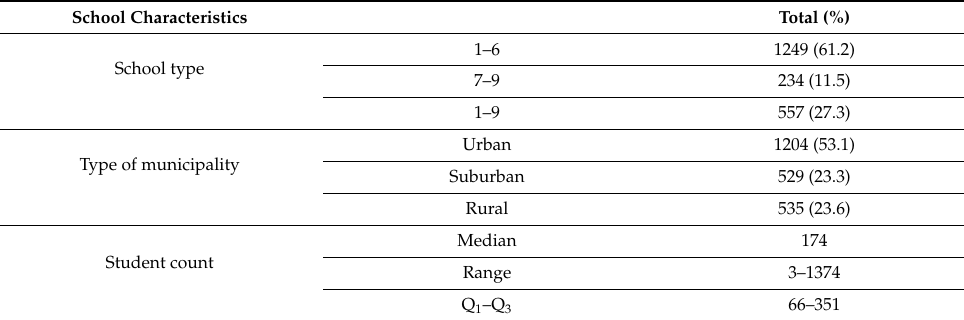
Table 1. School characteristics in comprehensive schools ( n =